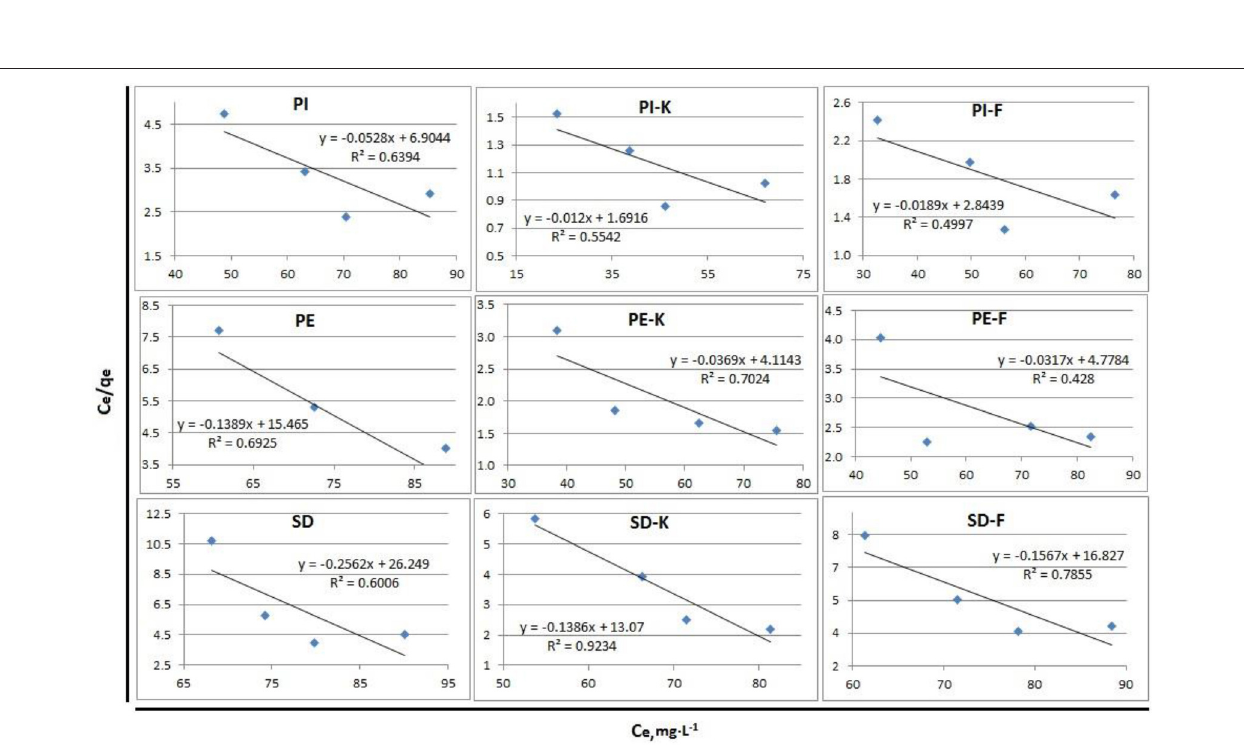
Frontiers in Environmental Science |